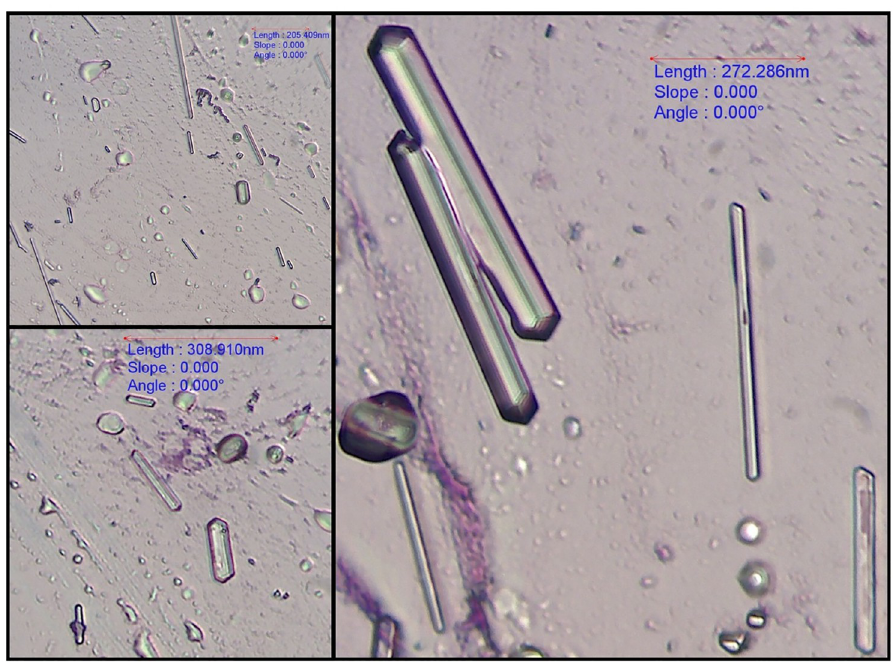
Fig 3. Cholesterol crystals. 40x. Diff-Quik stain, euromex CMEX 5 microscope camera.